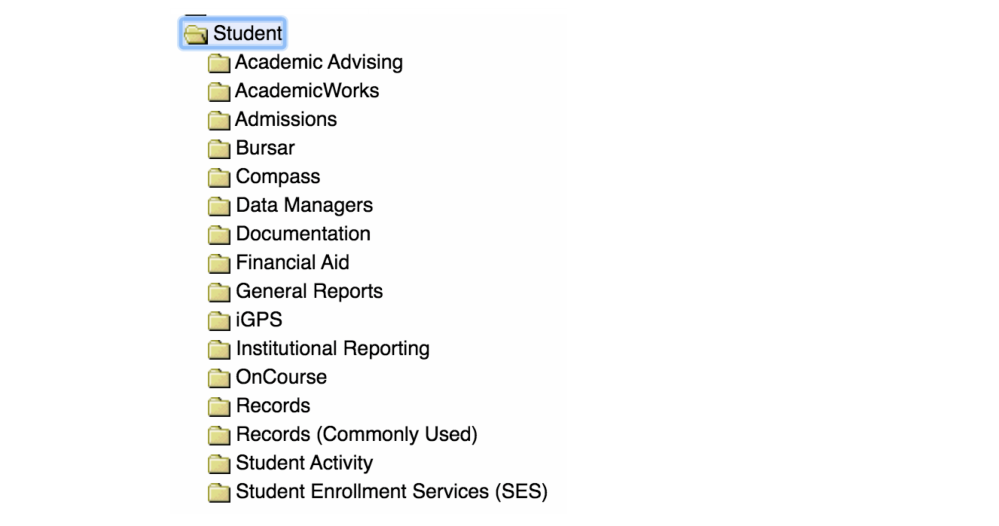
Figure 1. Views of one of ≥ 100 systems available for querying data at a midwestern university: an online folder menu for searching for data topics using an internal system.